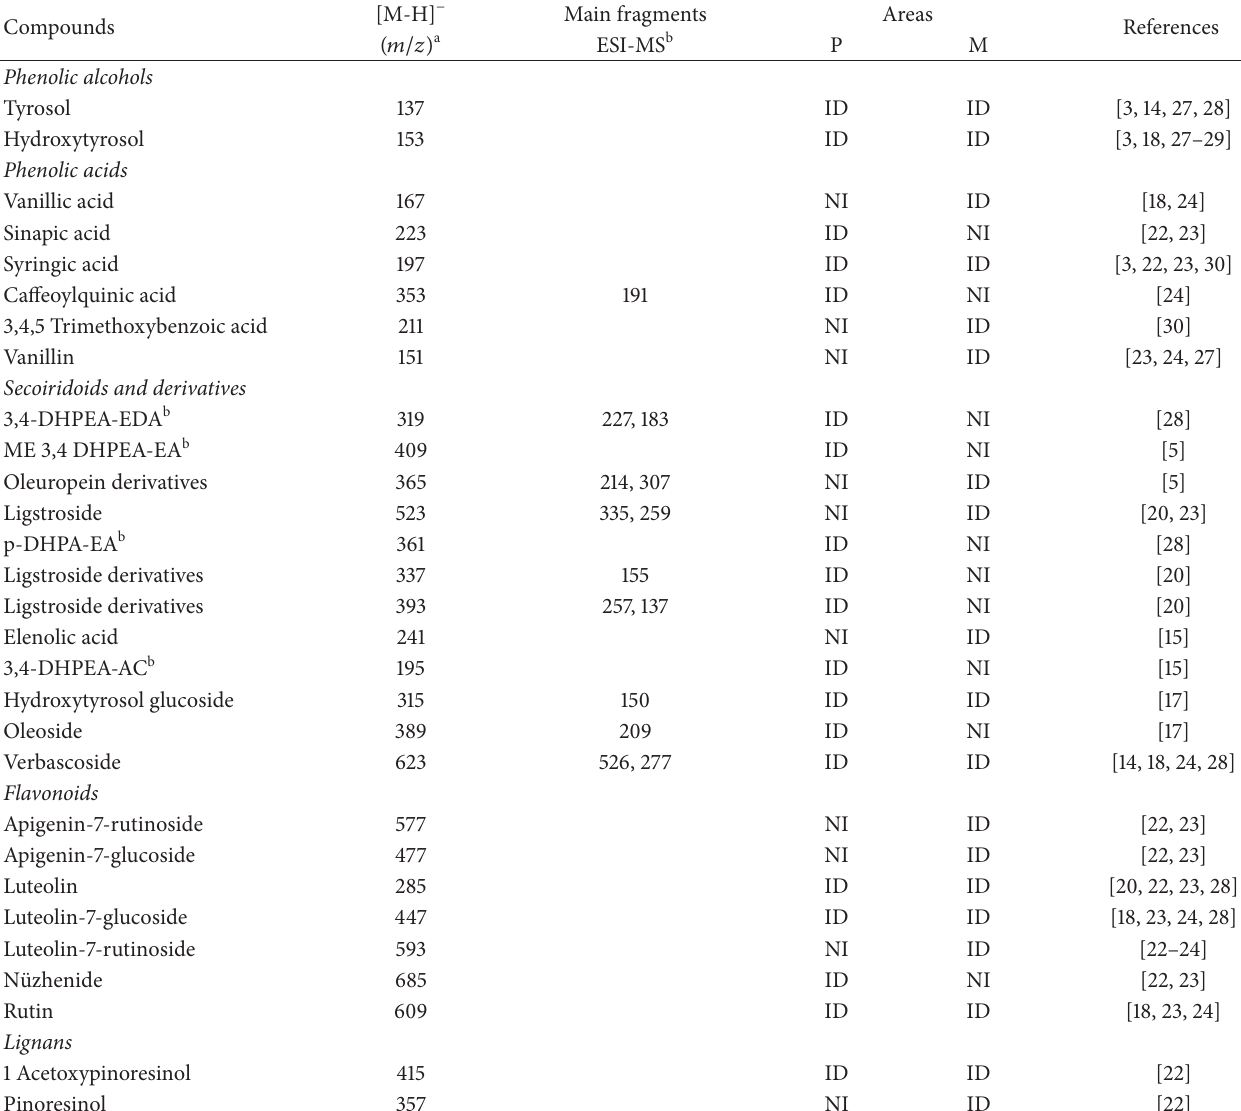
Table 3: Major phenolic compounds identified in OWWE.